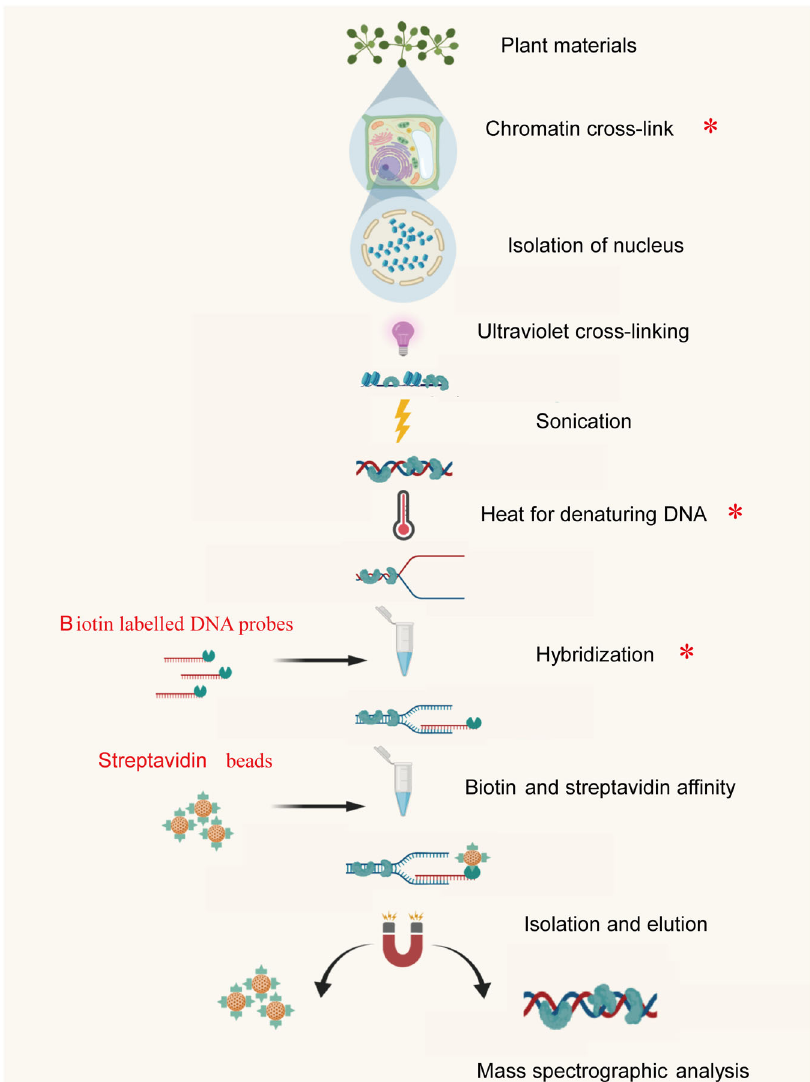
Fig. 1 Outlines of the reverse ChIP procedure. The plant material was treated with formaldehyde for DNA and protein cross-linking, and nuclei were isolated using sucrose density gradient centrifugation. Then the chromatin was sonicated to shear chromatin into small fragment. A set of probes labeled with biotin was added to the sonicated chromatin, and heated at 90 °C for 2 min to denature the chromatin so that the probes can bind to the denatured DNA sequence. Hybridization was then performed to anneal probes and chromatin. After hybridization, streptavidin magnetic beads were used to af fi nity the probes with biotin for collecting the hybridized chromatin. After washing to remove contamination, the hybridized chromatin was eluted, and DNA- associated proteins were subjected to mass spectrographic analysis. Asterisk (*) indicates the steps that need to be studied for optimization in this